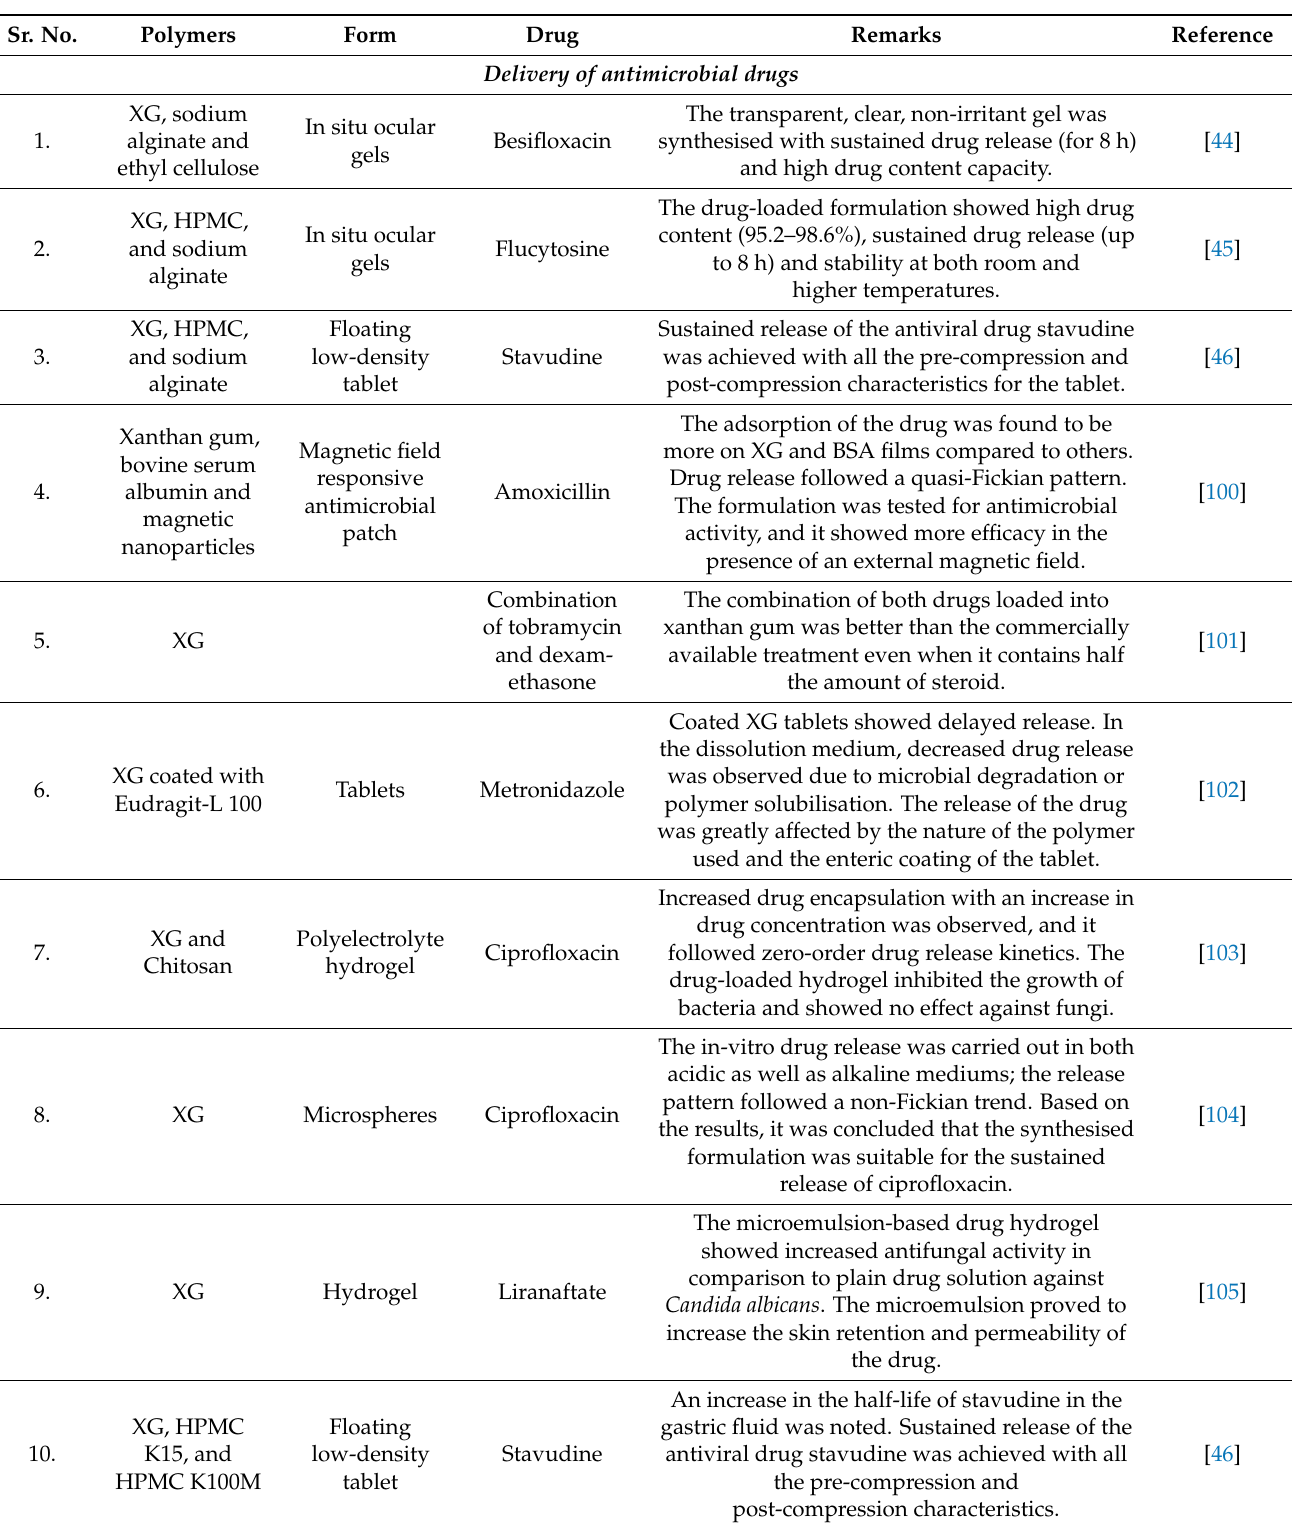
Table 2. Summary of polymers, dosage forms, drugs, and their